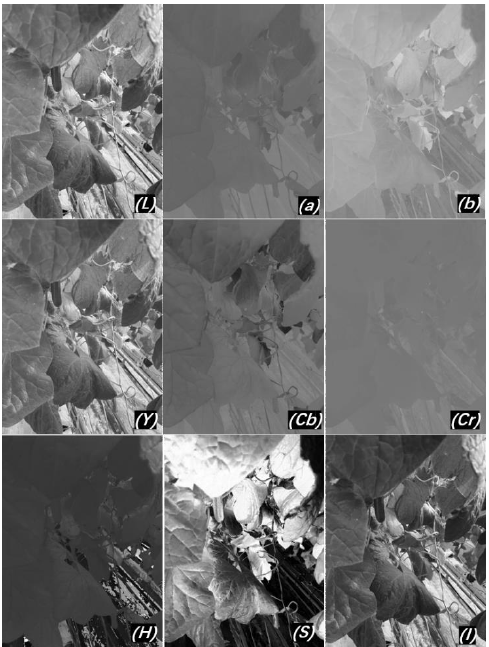
Figure 6. The first row is the image in the La*b* color space, with the L , a* and b* channels; the second row is the YCbCr color space, with Y , Cb , Cr channels; and the third row is the HSI color space, with the H , S and I channels.